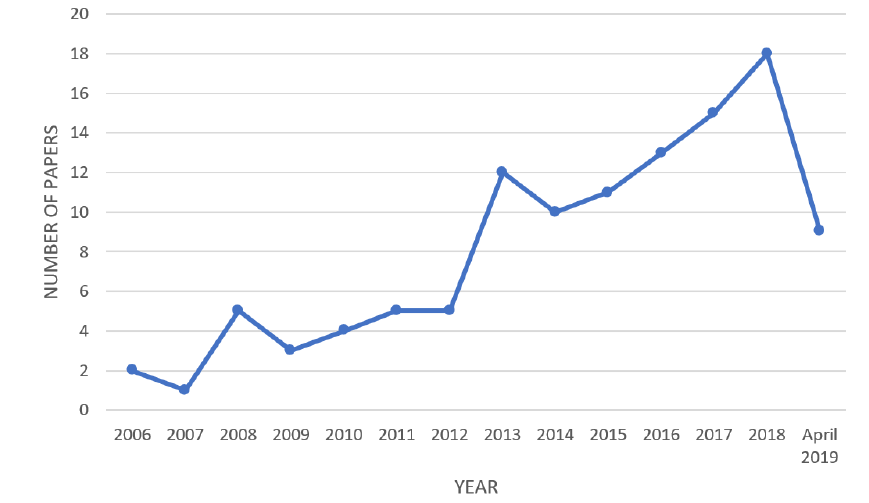
Figure 3. Number of papers found for each year during the paper selection